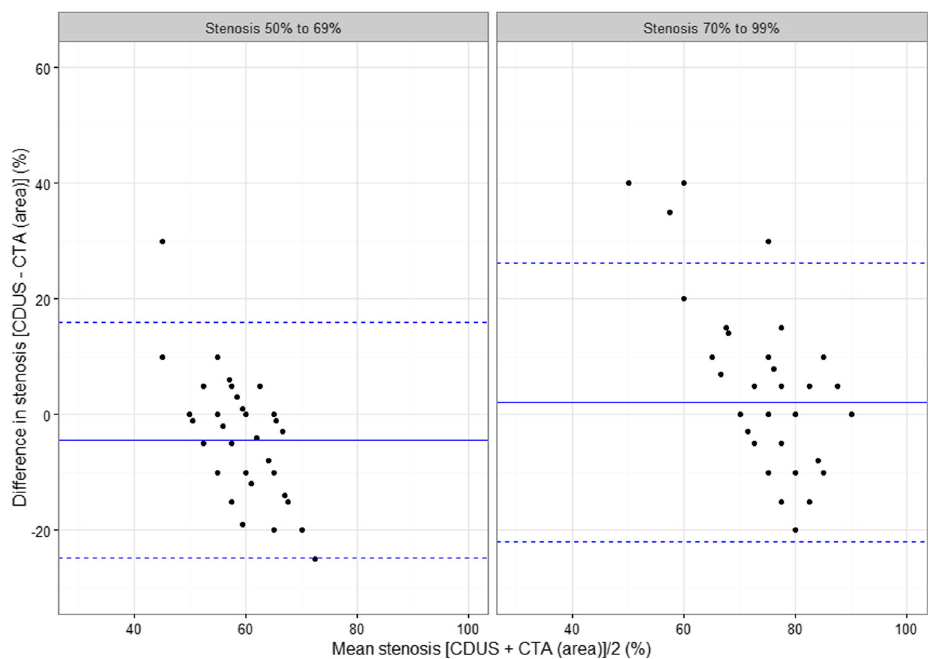
Fig. 3 Bland-Altman plot of the